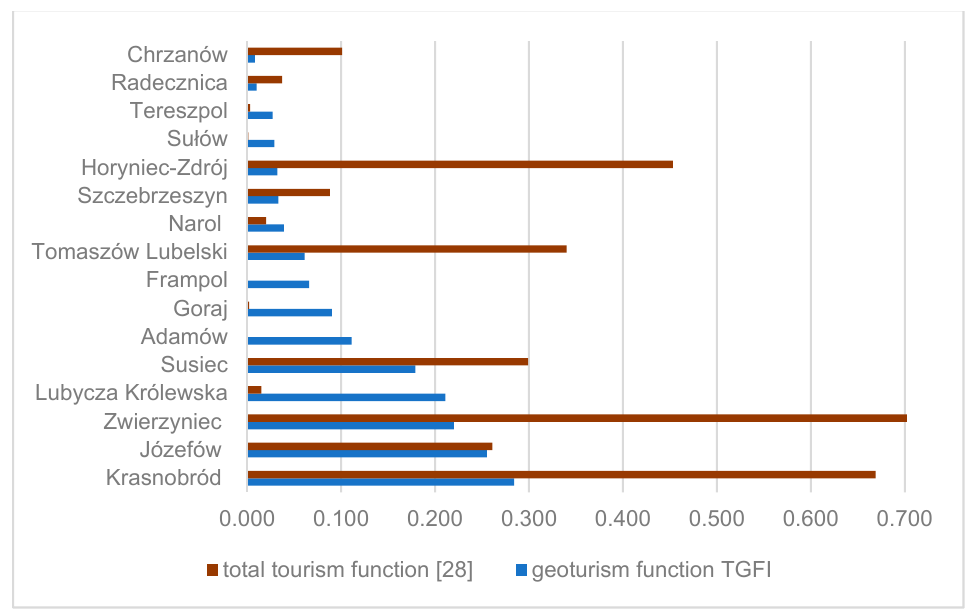
Figure 11. Comparison of the geotourism function (TGFI) in the analyzed communes with the values of the overall tourism function [28].